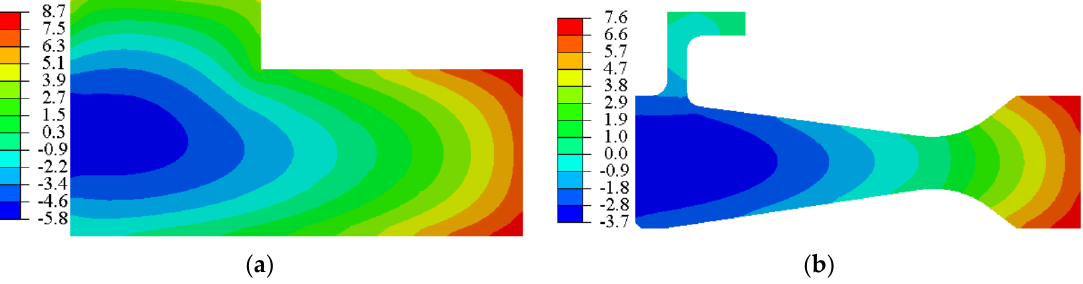
Figure 6. The maximum residual hoop stress and the strain energy of the whole model of the WQ method.